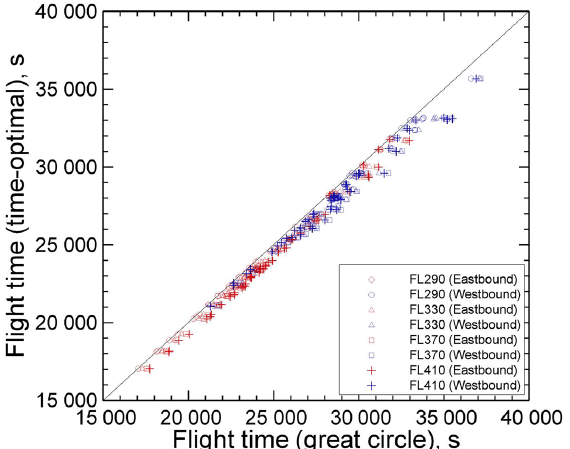
Figure 20. Comparison of the flight time for individual flights. A symbol indicates the value for one airport pair, corresponding to the time-optimal and great circle flights. If the value for the time- optimal flight is the same as that of the great circle flight, the symbol lies on the 1 : 1 solid